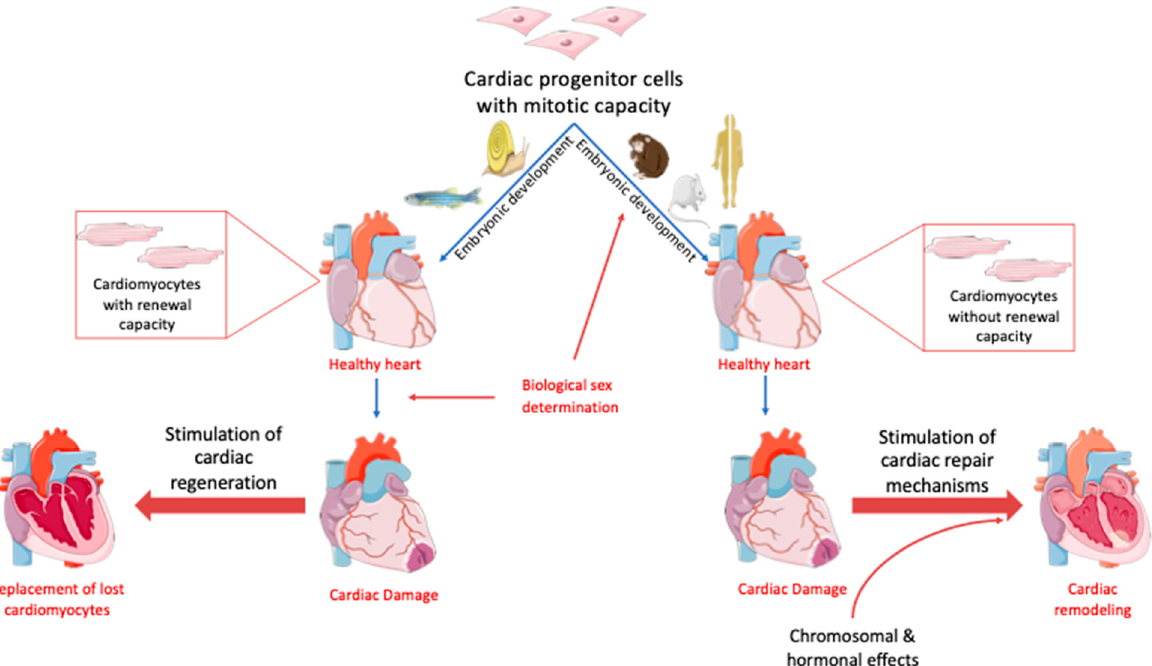
Figure 2. Sex determination–heart axis: sex determination is associated with cardiac regenerative capacity. Organisms with fluid sex determination, such as amphibians, zebrafish, newts and axolotls, retain cardiac regenerative capacity post-injury. In contrast, in mammalian organisms, where sex determination is permanent and takes place during development, cardiomyocyte renewal capacity is lost shortly after birth. Figures were produced using Servier medical art.